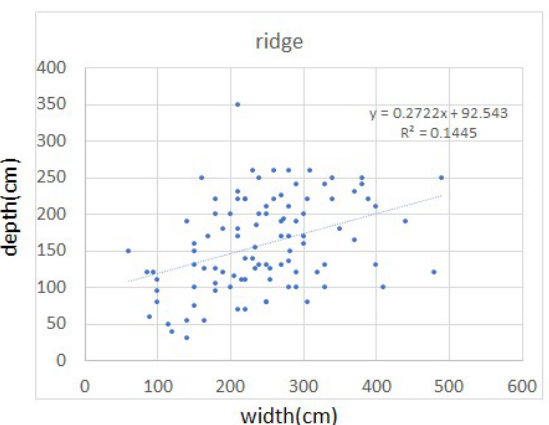
Figure 7 . Relationship between depth of roots and width of roots in ridge